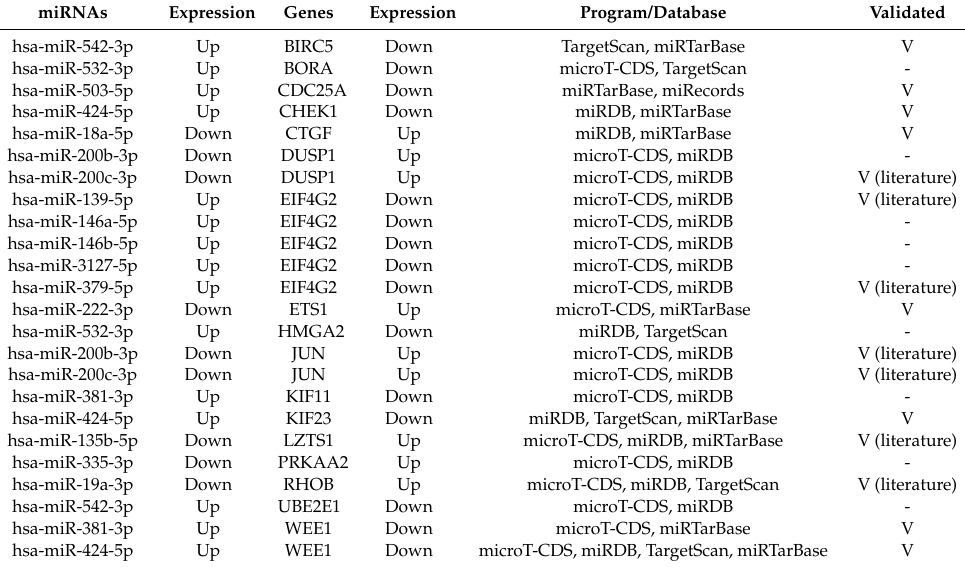
Table 1. Cell-cycle-related miRNA-mRNA interactions were identified by interactive network analy- sis. miRNA-mRNA predicted and validated interactions collated from cell cycle network analysis, which were identified in two or more programs or databases. V = validated targets from miRTarBase or miRecords, V (literature) = validated targets that did not appear in miRTarBase or miRecords but were found to be validated in the literature or (-) representing unvalidated targets. Genes